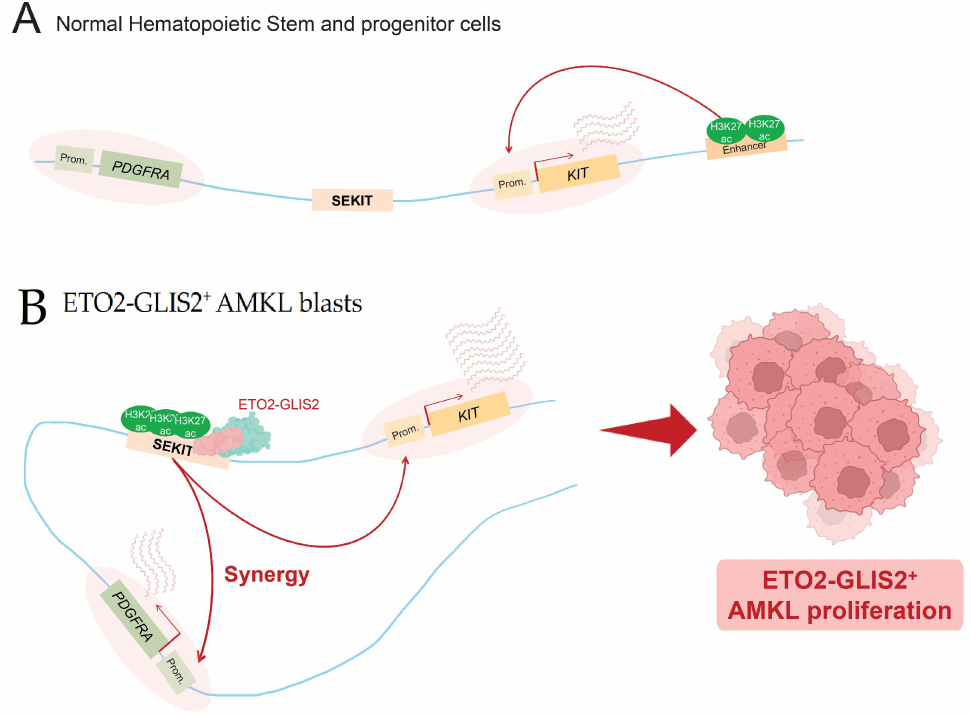
Figure 4. Super-enhancer hijacking by ETO2-GLIS2 fusion. ( A ) In normal hematopoietic stem and progenitor cells, PDGFRA gene is not expressed and KIT expression is mainly driven by an enhancer located 3 (cid:48) of its transcription termination site. ( B ) In AMKL blasts, ETO2-GLIS2 fusion is able to bind and hijack a de novo super-enhancer, termed SEKIT. This leads to the abnormal activation of SEKIT and the subsequent expression of two tyrosine kinase encoding genes, KIT and PDGFRA , involved in ETO2-GLIS2 + AMKL